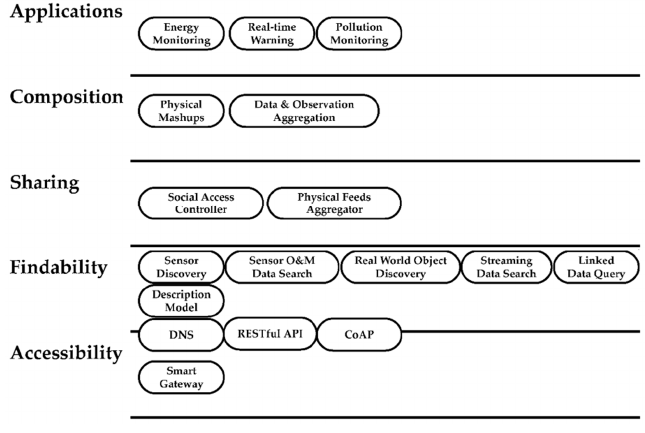
Figure 2. WoT System Model.